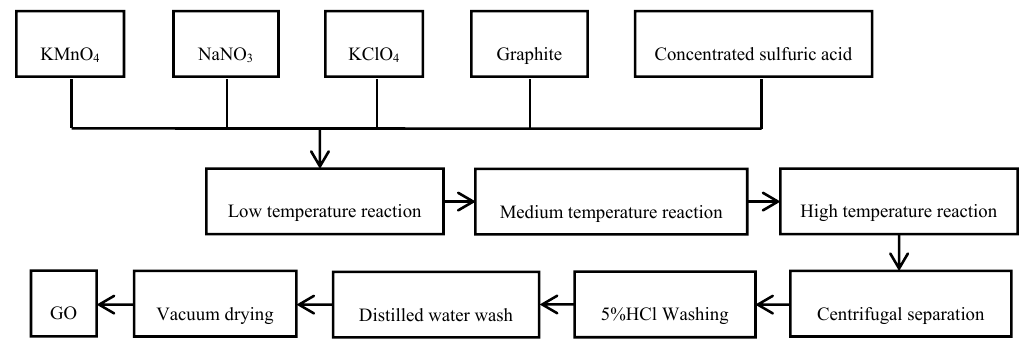
Figure 1. Flow chart of preparation of graphite oxide.